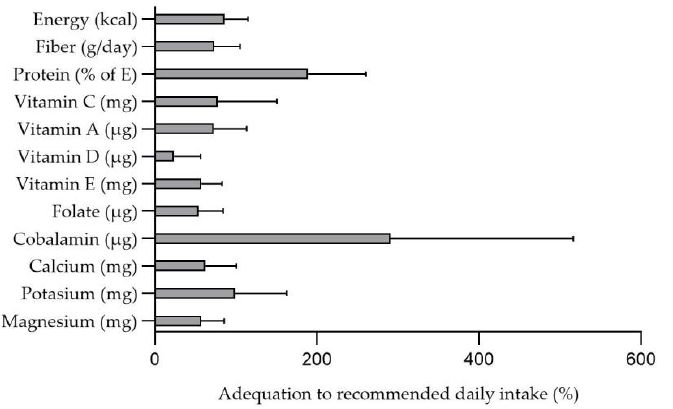
Figure 3. Percentage of adequacy for energy intake, fiber, protein, and micronutrients, recommended daily intake in children with celiac disease (n = 58).